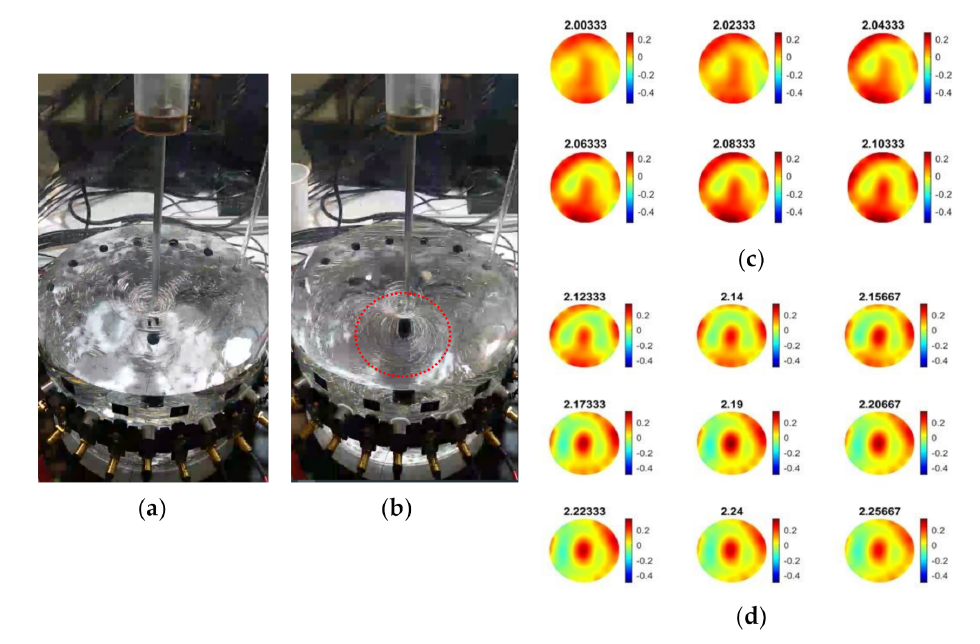
Figure 6. Monitoring the mixing process of 100 g of particle beads (diameter 4 mm) with USCT. ( a , b ): Experimental images of mixing at 200 RPM and the formation of a central vortex in the tank. ( c , d ): USCT-based tomographic reconstructions between 2 min and 2.25 min, showing the process of mixing. Amount of particles: 100 g, water volume: 3